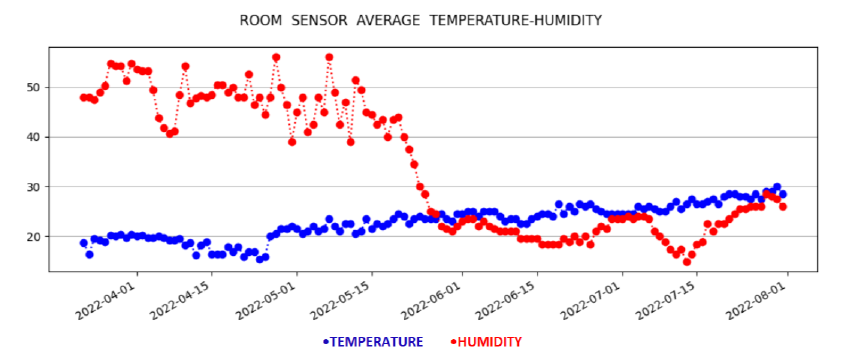
Figure 4. Temperature and humidity time plots in reference room.